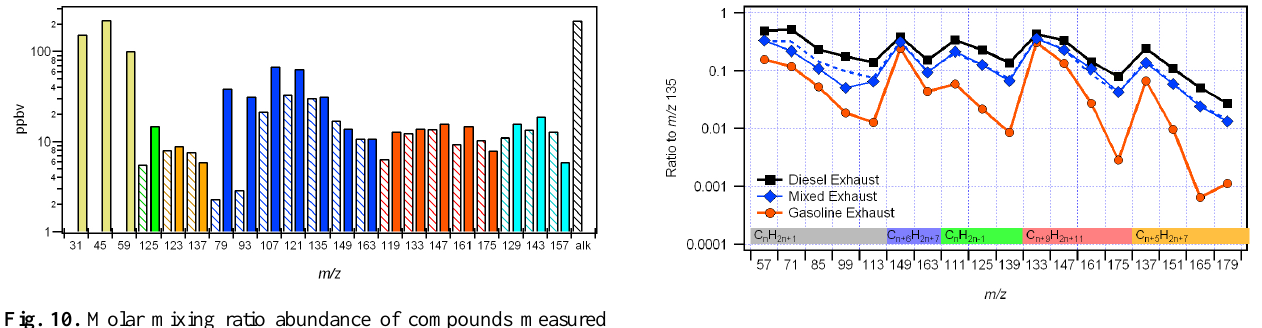
Fig. 11. PTR-MS IVOC mode exhaust fingerprints observed for diesel exhaust (black squares), gasoline exhaust (red circles), and an approximately 50:50 mixture (blue diamonds). The dashed line is a calculated exhaust fingerprint of a 50:50 mixture of gasoline and diesel exhaust given the source profiles shown. Color bands in- dicate compound group: alkane fragment ions (gray), alkylbenzenes (blue); cycloalkane fragment ions (green), naphthenic monoaromat- ics (red); bicycloalkanes